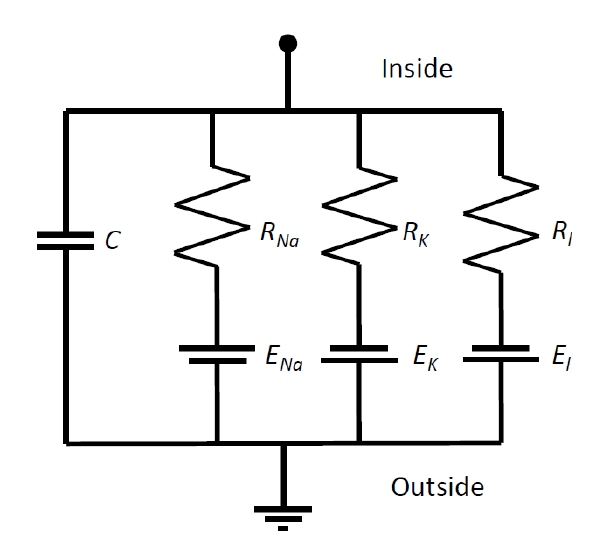
Fig. 9: Equivalent electrical circuit of the Hodgkin-Huxley nerve membrane model in its original form. Here, “inside” and “outside” denote the interior and exterior of the cell with the membrane separating these two parts. Furthermore, C is the membrane capacitance, R Na and R K describe the sodium and potassium time-varying conductivities, respectively, R l describes the leakage resistance, E Na , E K , and E l are the reverse ion channel potentials.